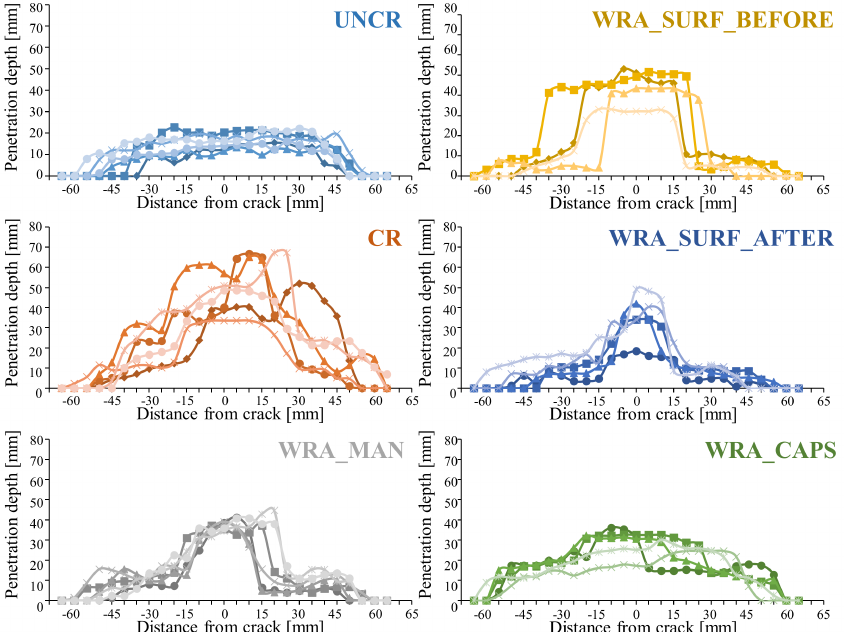
Figure 11. Visualization of the chloride ingress front for each of the different test series (different shades of the colours are used to represent the repetitions per test series).